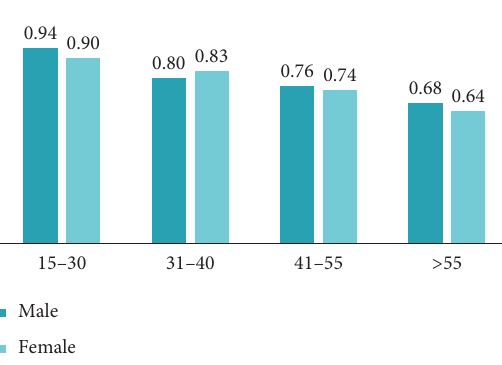
Figure 17: Accuracy of experiments by age groups.